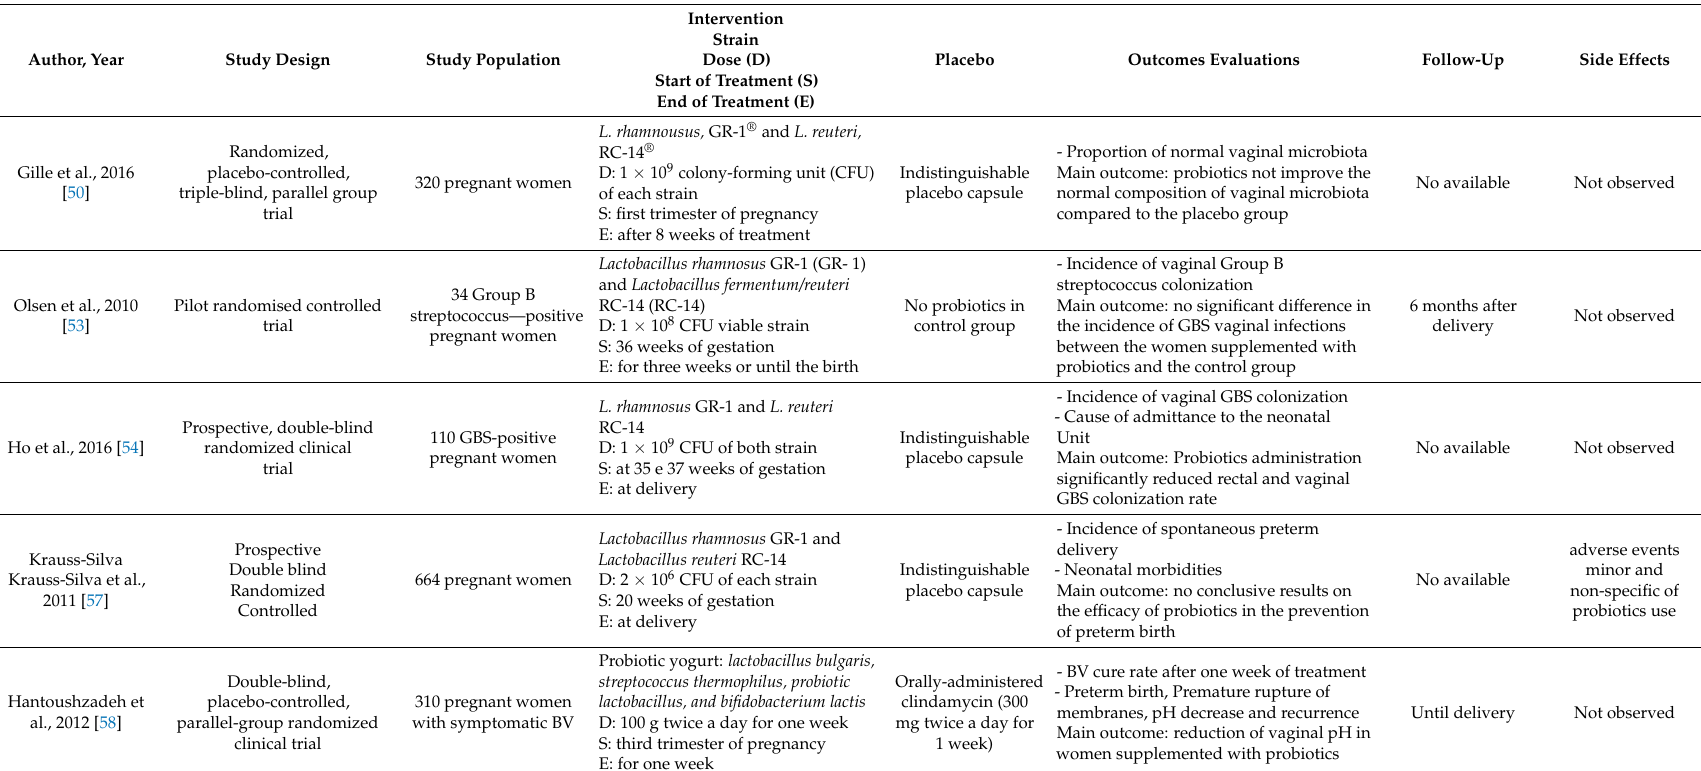
Table 1. Role of probiotics administration in the prevention of infection and preterm delivery during